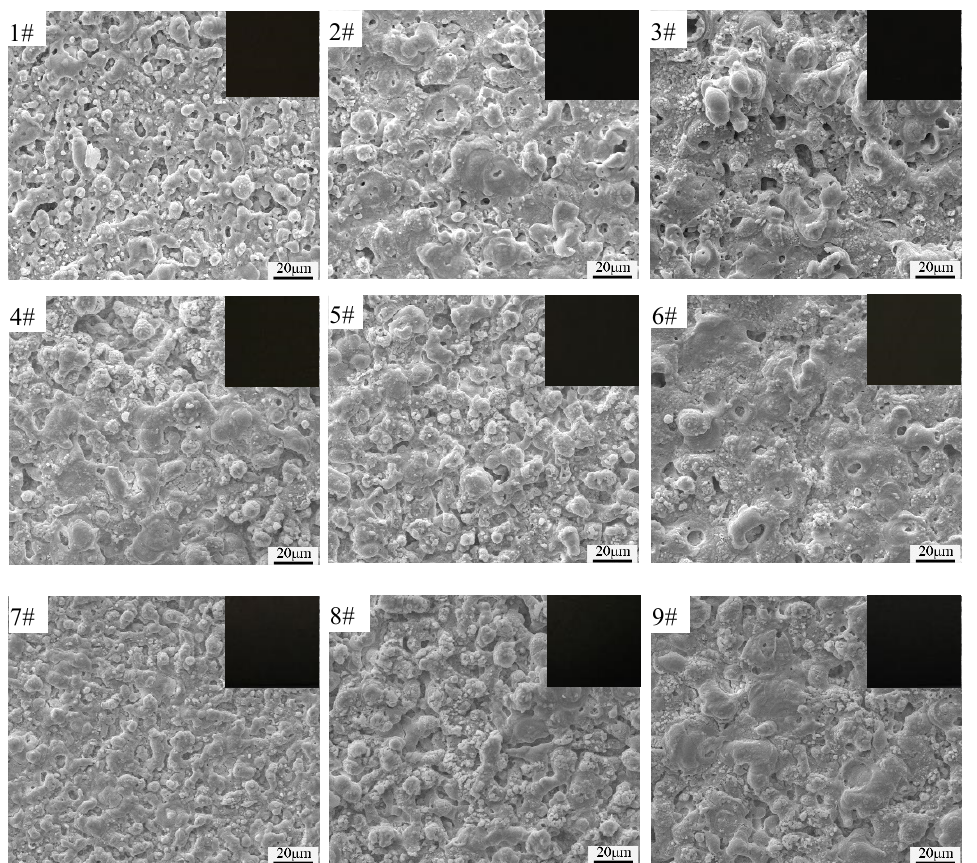
Figure 1. SEM surface micrographs and digital photographs (in the upper right corner of each photo) of black MAO coating samples 1 # − 9 # .